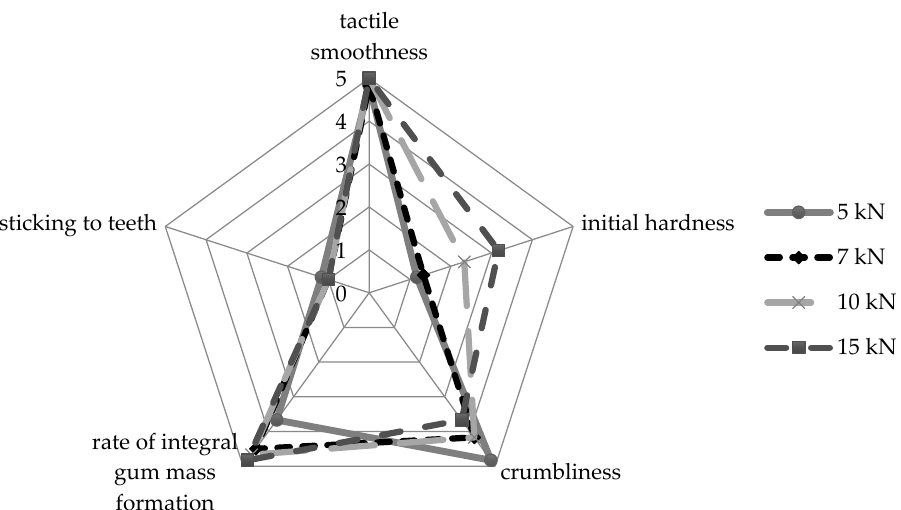
Figure 4. Diagram of average chewing perception scores for MCG batches compressed at different compression forces. According to average scores, change of compression force applied during the produc- tion process does not lead to significant differences in such criteria as “tactile smoothness” and “sticking to teeth”. All samples of MCGs were perceived as smooth (average scores ranged from 4.83 ± 0.37 both for 5 and 7 kN to 5.00 ± 0.00 for the other batches) and not sticking to teeth (from 1.00 ± 0.00 for 7, 10, 15 kN to 1.17 ± 0.37 for 5 kN batch). This indicates that differences that are registered by in vitro methods described above (i.e.,